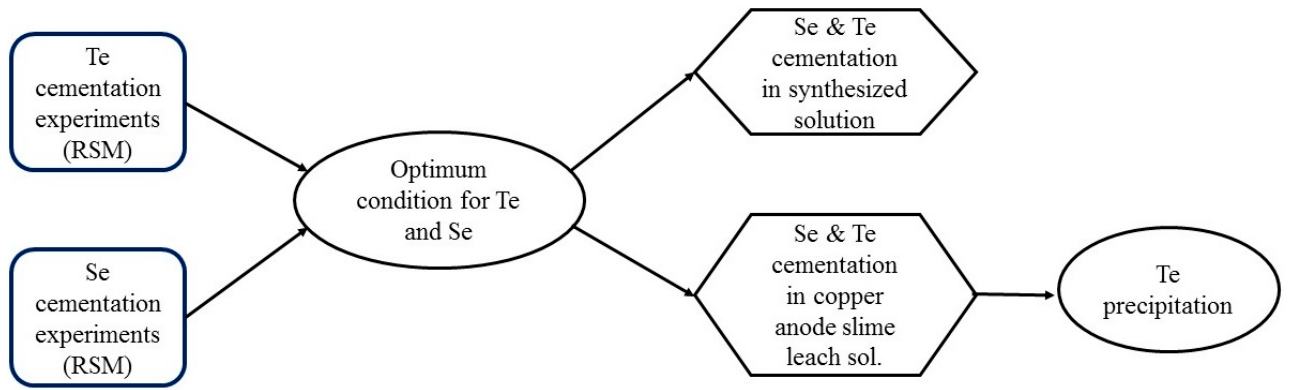
Figure 1. Flowchart for Se and Te cementation process by solid copper